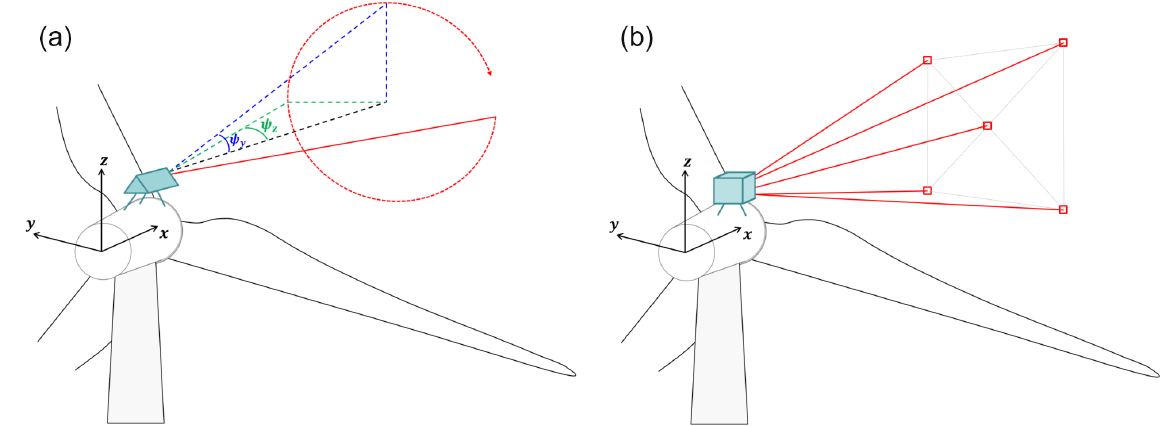
Figure A1. Schematic view of the measurement patterns of nacelle-mounted lidars: CW lidar (a) and PL lidar (b) .